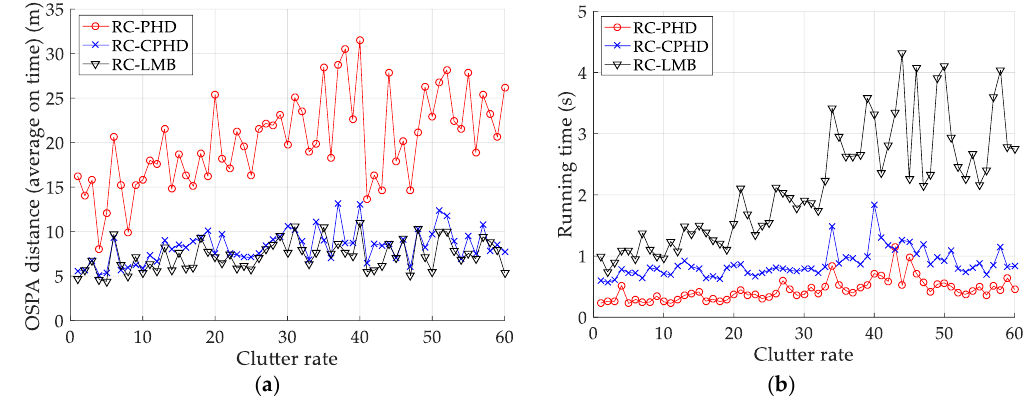
Table 9. Average OSPA distance and running time of different filters versus detection probability when the clutter rate is equal to 6.